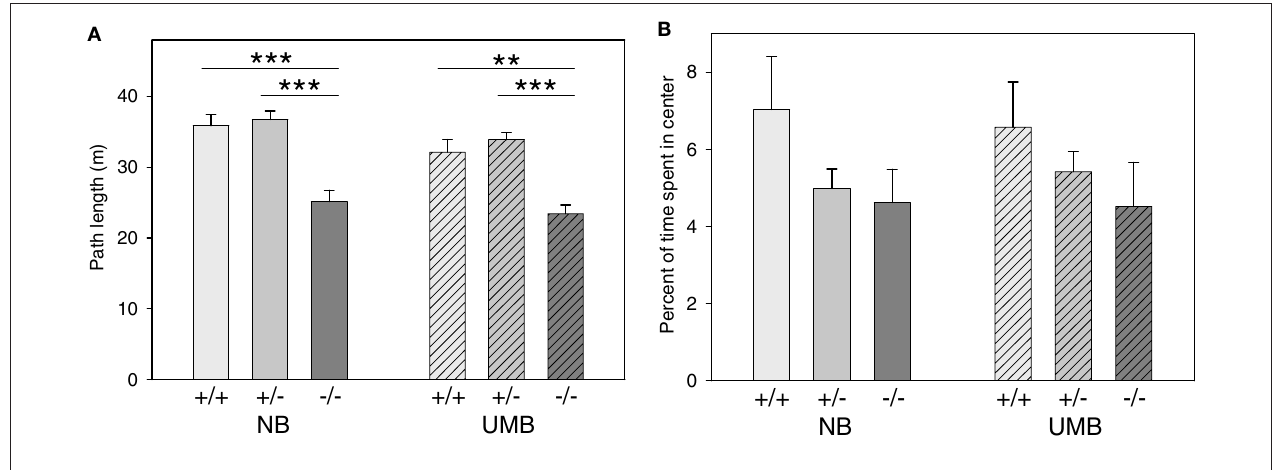
FIGURE 4 | Open fi eld test. NB, neutral bedding; UMB, unfamiliar male bedding; + / + , + / − , − / − : 5-HTT genotypes. Data are shown as mean + SEM. Statistics: ANOVA, post hoc testing: Bonferroni corrected t -tests: *** P < 0.001, ** P < 0.01. Data were obtained from 36 NB males (6 + / +